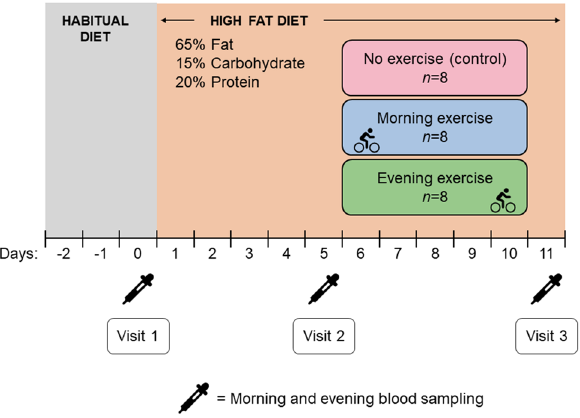
Figure 6. Experimental design. All participants consumed a high-fat diet for 11 days. Two groups of participants exercised daily on day 6–10, either in the morning ( n = 8) or in the evening ( n = 8), and one group of participants ( n = 8) remained inactive during the whole study period (control group). Blood samples were obtained in the morning (fasted) and in the evening (postprandial) at baseline (Visit 1), after 5 days of high-fat diet (Visit 2), and at study completion (Visit